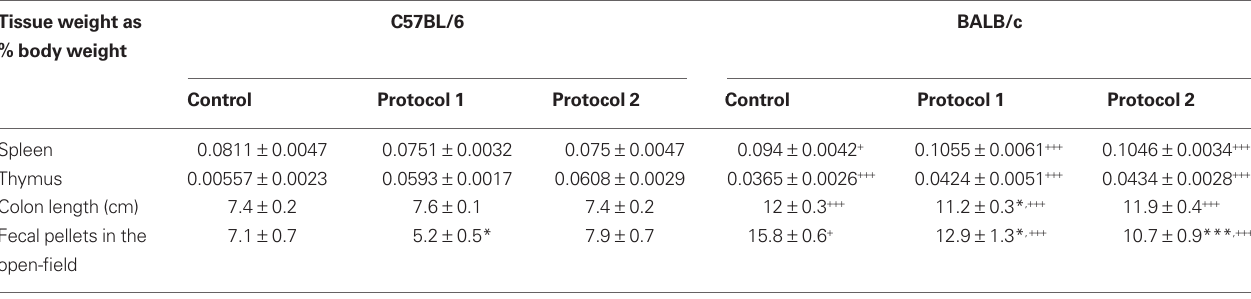
Table 2 | effect of MS on physiological